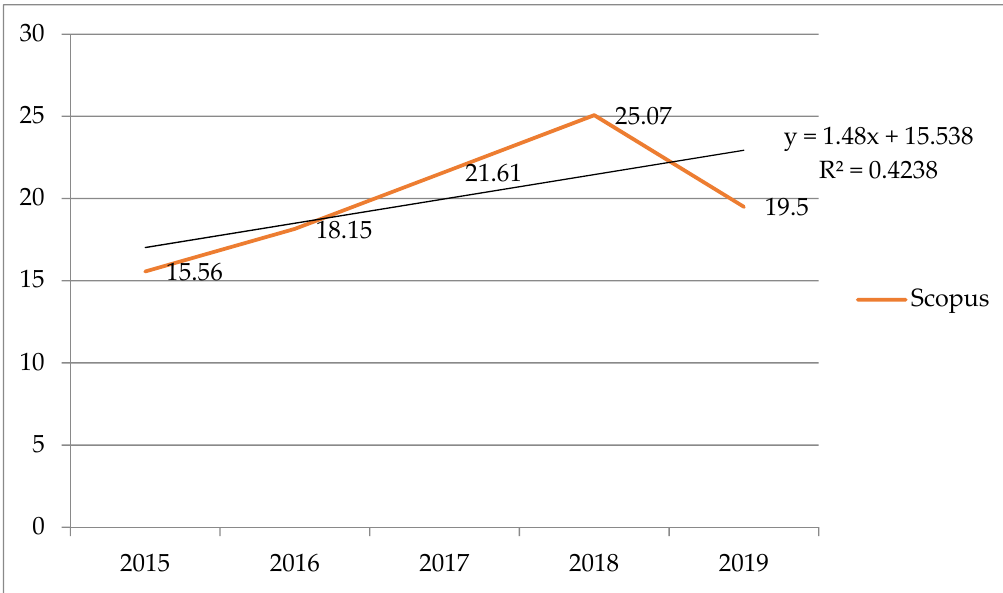
Figure 2. Diachronic production of the scientific production indexed in the Web of Science database.